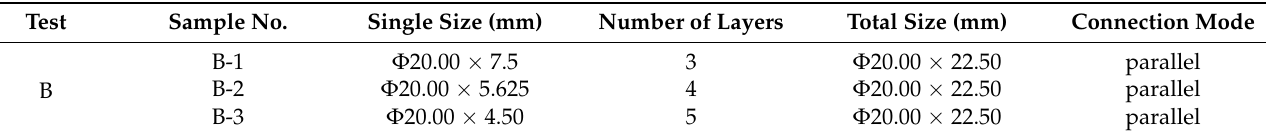
Figure 10. The specimens of Test B. Table 4. Size parameters of the specimens in Test B.